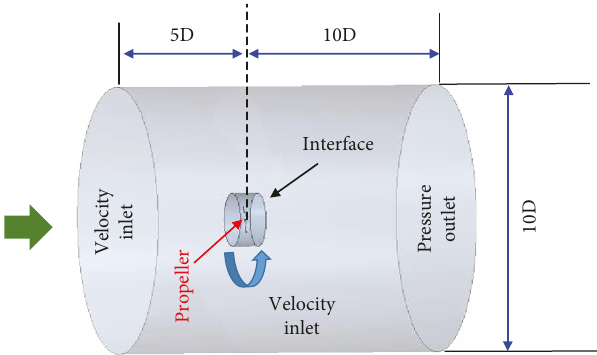
Figure 18: Computational domain and boundary conditions for the case of the propeller alone. Table 6: Comparison of performance at design point. Thrust (N) Torque (Nm) E ffi ciency (%) Design